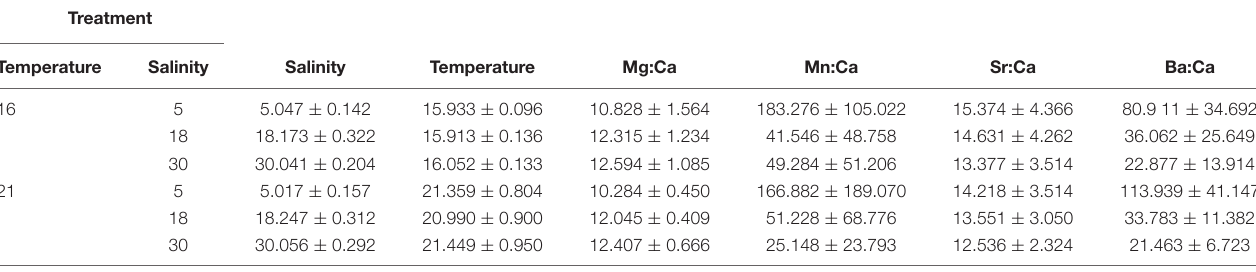
TABLE 1 | Summary of the experimental conditions of salinity and temperature along with water Me:Ca ratios in each treatment, showing mean and standard deviation of water salinity, temperature ( ◦ C), and Mg:Ca Water (mol mol − 1 ), Mn:Ca Water ( µ mol mol − 1 ), Sr:Ca Water (mmol mol − 1 ) and Ba:Ca Water ( µ mol mol − 1 ) ratios. Treatment